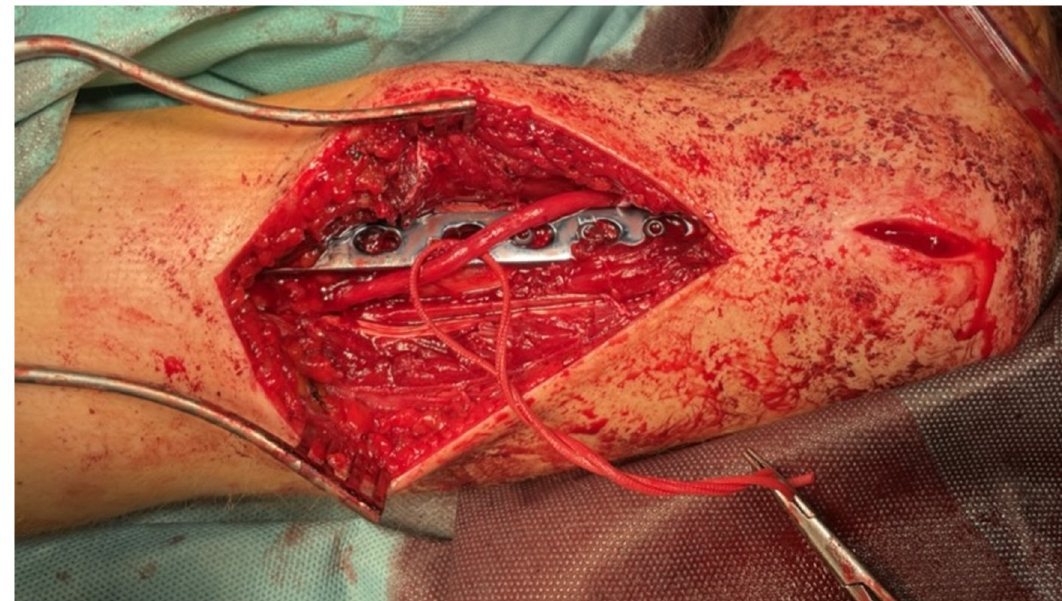
Figure 1. Patient No. 6. post-traumatic X-rays; subsequent control X-rays after close reduction and internal fixation/flexible intramedullary nailing (CRIF/FIN) showing increasing displacement of the bone fragments.